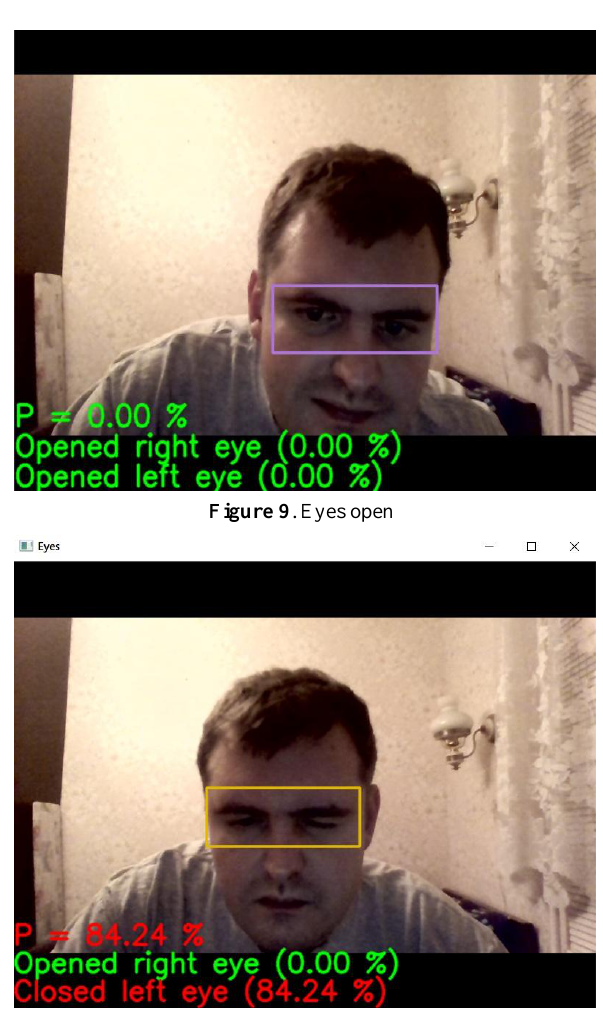
Figure 10 . One eye closed